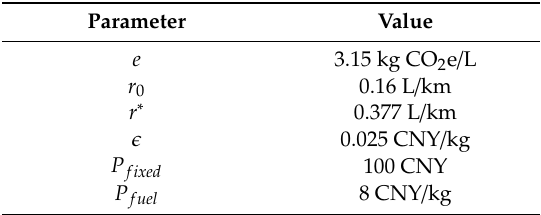
Table 6. Parameters of vehicles.